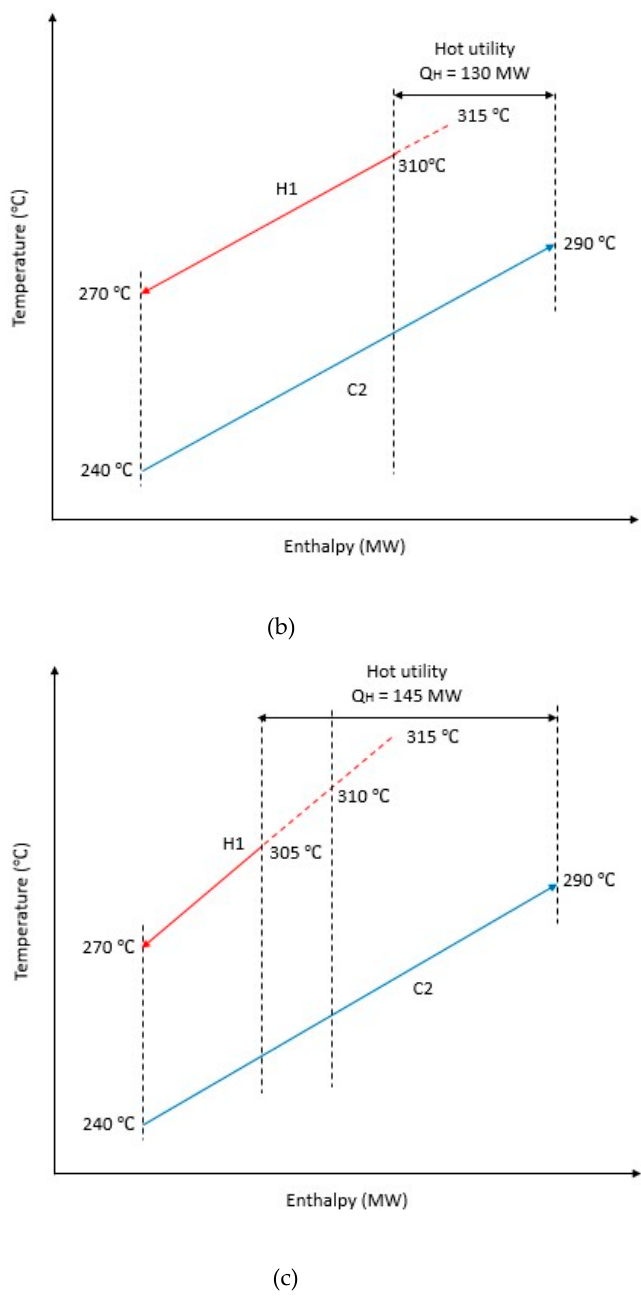
Figure 15. ( a ) The plus-minus principle with increasing T S by 5 ◦ C for H1; ( b ) The PLUS-MINUS principle for nominal T S for H1 considering maximum size of HE and a bypass; ( c ) The plus-minus principle with decreasing T S by 5 ◦ C for H1 considering maximum size of HE and a bypass.